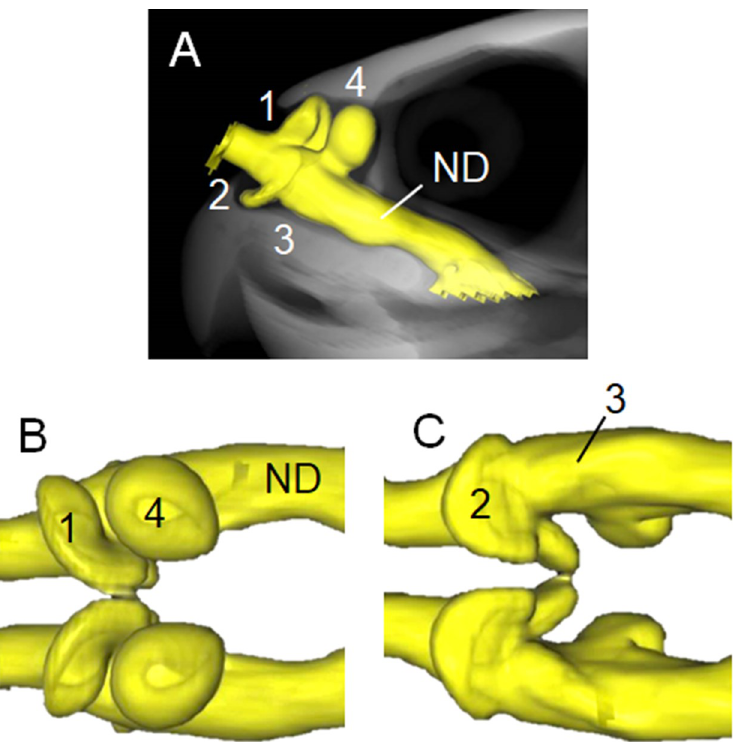
Fig 3. Three-dimensional reconstructions based on computed tomography images of nasal cavity of olive ridley sea turtle. (A) Left lateral view of nasal cavity structure (yellow) at anterior region of skull. Dorsal (B) and ventral (C) views of nasal cavity. Anterodorsal (1), posterodorsal (4) and anteroventral (2) diverticula, and small posteroventral salience formed by fossa on wall (3) in cavum nasi proprium anterior to nasopharyngeal duct (ND). See also S2 Video.